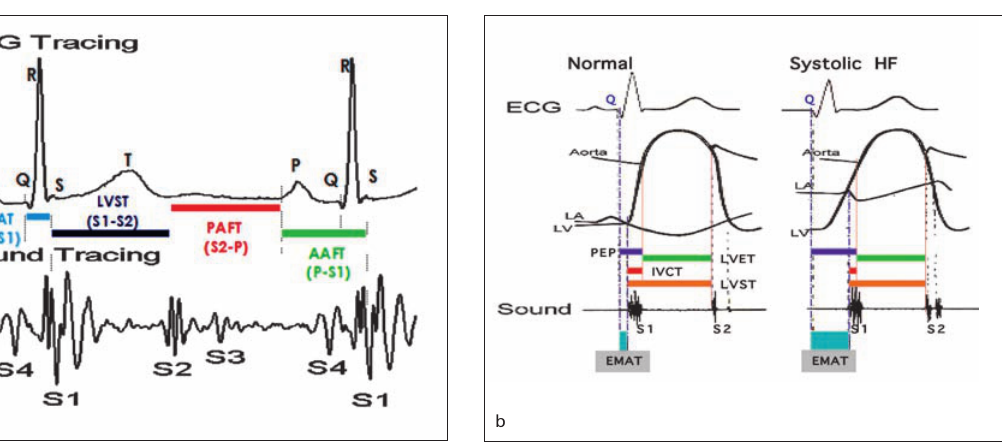
several acoustic car- diographic